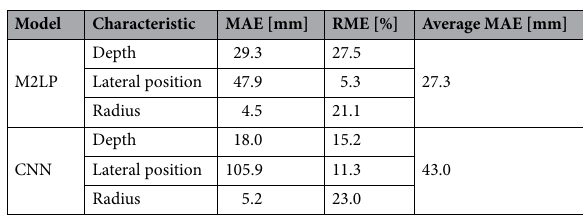
Table 11. Prediction performance of considered characteristic parameters for M2LP and CNN models by using real data set obtained from measurements.